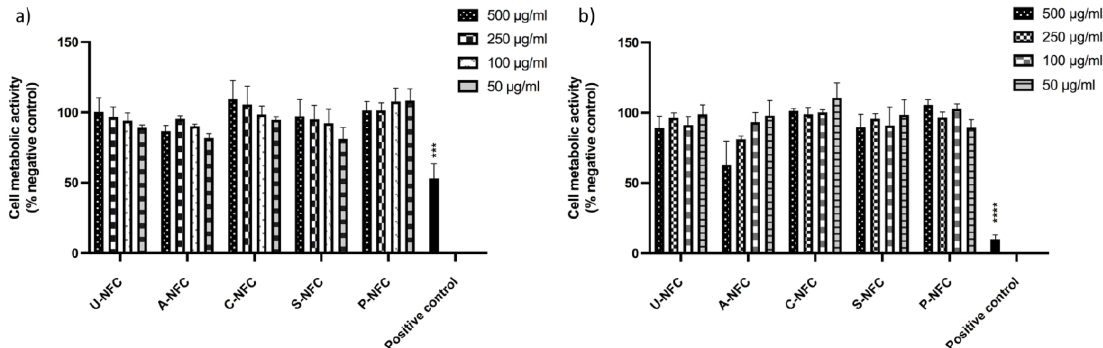
Figure 3. Cell metabolic activity of Caco-2 cells after exposure to the NFC materials. ( a ) 24 h exposure; ( b ) 48 h exposure. Data are expressed as percentage of the negative control (untreated cells) and presented as mean ± SEM of three independent experiments. Significant results as compared with the negative control area marked with asterisks (*** p < 0.001, **** p < 0.0001).